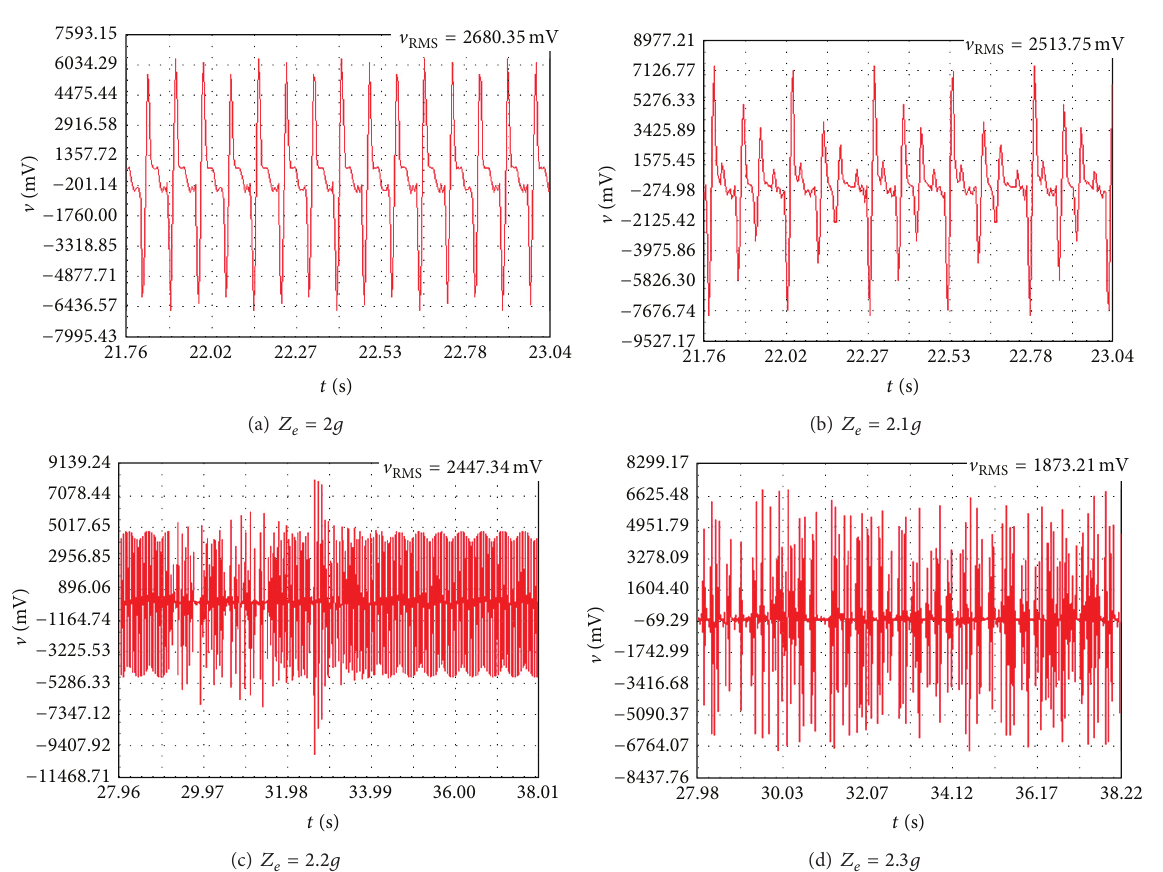
Figure 20: Experimentally obtained time series of output voltage for 𝜔 𝑒 = 12 Hz with different 𝑍 𝑒